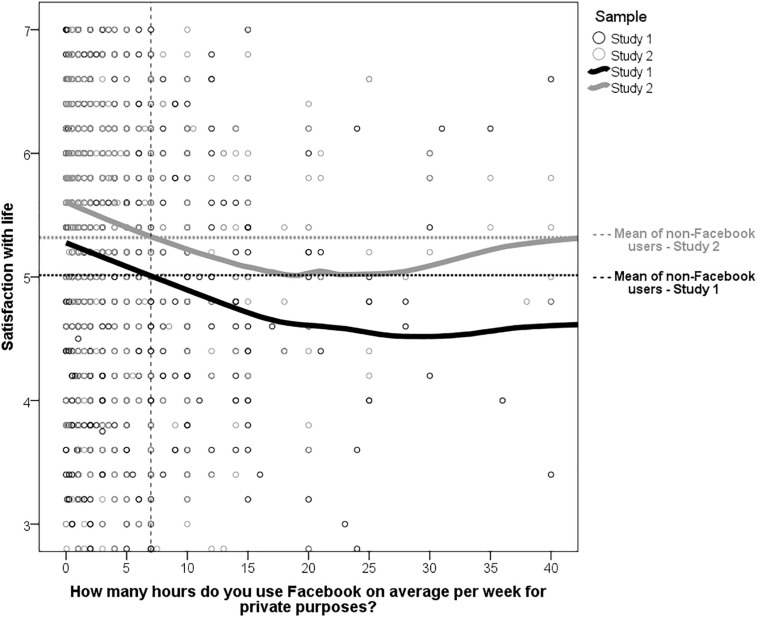
Association between life satisfaction and the hours per week (on average) being on Facebook. For clarity, the non-log-transformed variables were used. The regression lines represent LOESS curves (i.e., local regressions using Epanechnikov kernel, nearest neighbor function = 99%). Dashed horizontal lines represent the mean life satisfaction of non-Facebook users. Dashed vertical line represents the mean hours per week on Facebook where life satisfaction is lower than in the control group (i.e., non-Facebook users).